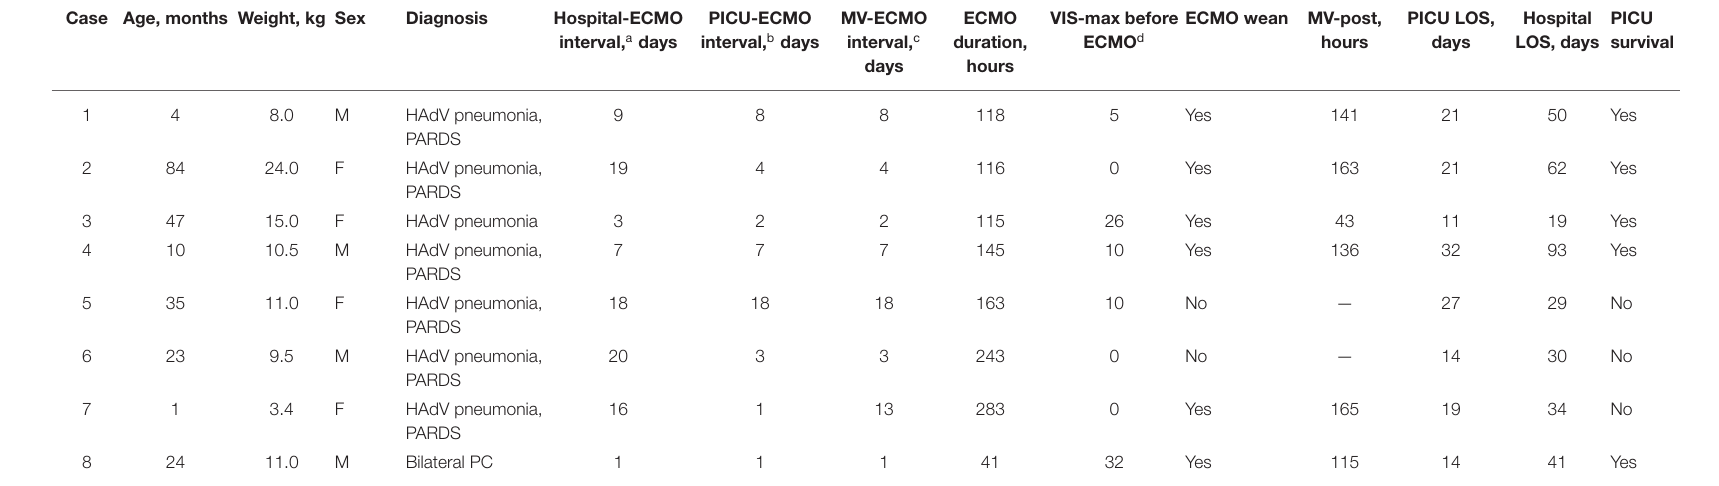
TABLE 1 | Patients’ demographics and clinical characteristics. Case Age, months Weight, kg